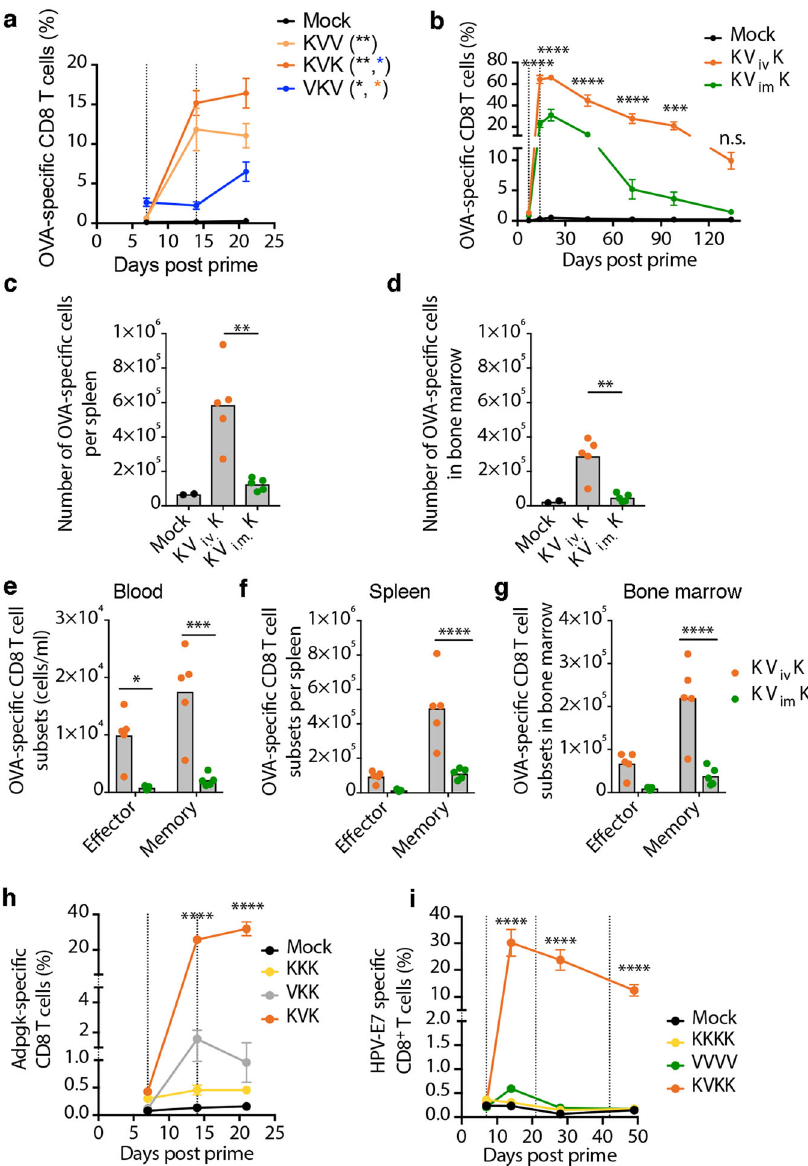
Fig. 1 Heterologous prime-boost vaccination with KISIMA-TAA and VSV-GP-TAA is superior to homologous vaccination with either vaccine platform. a C57BL/6J mice ( n = 5) were immunized against ovalbumin with either KISIMA-OVA given s.c. (K) or VSV-GP-OVA (V) administered i.m. on days 0, 7, and 14 (dotted lines) or left untreated (mock). The fraction of OVA-speci fi c cells among CD8 + T cells in peripheral blood is shown. Two-way ANOVA with Tukey ’ s multiple comparisons (*, p <0.05; **, p <0.01). b – g C57BL/6J mice were immunized with KISIMA-OVA (s.c.) on day 0 and 14 and VSV-GP-OVA was administered either i.m. or i.v. on day 7 as indicated by dotted lines ( n = 5 per treatment group, n = 2 for mock). b The frequency of OVA-speci fi c CD8 + T cells in circulation is depicted. Two-way ANOVA with Sidak ’ s multiple comparison (**, p <0.01). c , d The number of OVA-speci fi c CD8 + T cells in the ( c ) spleen and ( d ) bone marrow of immunized mice was measured 19 weeks post prime. One-way ANOVA with Tukey ’ s multiple comparison (**, p <0.01). e – g The number of OVA- speci fi c CD8 + T cells with effector (KLRG1 + CD127 − ) and memory precursor (CD127 + ) phenotype in ( e ) peripheral blood (cells/ml), ( f ) spleen and ( g ) bone marrow 19 weeks after prime is shown. Two-way ANOVA with Sidak ’ s multiple comparison (****, p <0.0001). ( h , i ) C57BL/6J mice were vaccinated against ( h ) Adpgk and Reps1 neoantigens or ( i ) HPV-E7 with either ( h ) KISIMA-Mad24 or ( i ) KISIMA-HPV given s.c. (K) or ( h ) VSV-GP-Mad24 or ( i ) VSV-GP-HPV administered i.v. (V) on day 0 and as indicated with dotted lines. The frequency of circulating CD8 + T cells speci fi c for ( h ) Adpgk ( n = 5 per group) and ( i ) HPV- E7 ( n = 7 per group) is depicted. Two-way ANOVA ( h ) and one-way ANOVA ( i ) with Tukey ’ s multiple comparison was performed (*** p <0.001; **** p <0.0001) and signi fi cance compared to mock is shown. All data shown as mean±SEM. Studies ( a , c – g ) were performed once, studies ( b , i ) were independently repeated once, study ( h ) was repeated once with the listed groups except VKK, which was only included once. Source data and p -values are provided in the Source Data File. frequency (Fig. 1i). Though subsequent boosting with KISIMA-HPV antigen models (Fig. 1h, i). Targeting E7, heterologous KVK did not further increase HPV-E7-speci fi c CD8 + cells frequency, it vaccination resulted in signi fi cantly higher antigen-speci fi c T cell did prevent them from undergoing dramatic contraction. Consistent responses compared to both homologous vaccinations, inducing an with the OVA model, HPV-speci fi c CD8 + T cells induced by over 30-fold increase in circulating HPV-E7-speci fi c CD8 + T cell